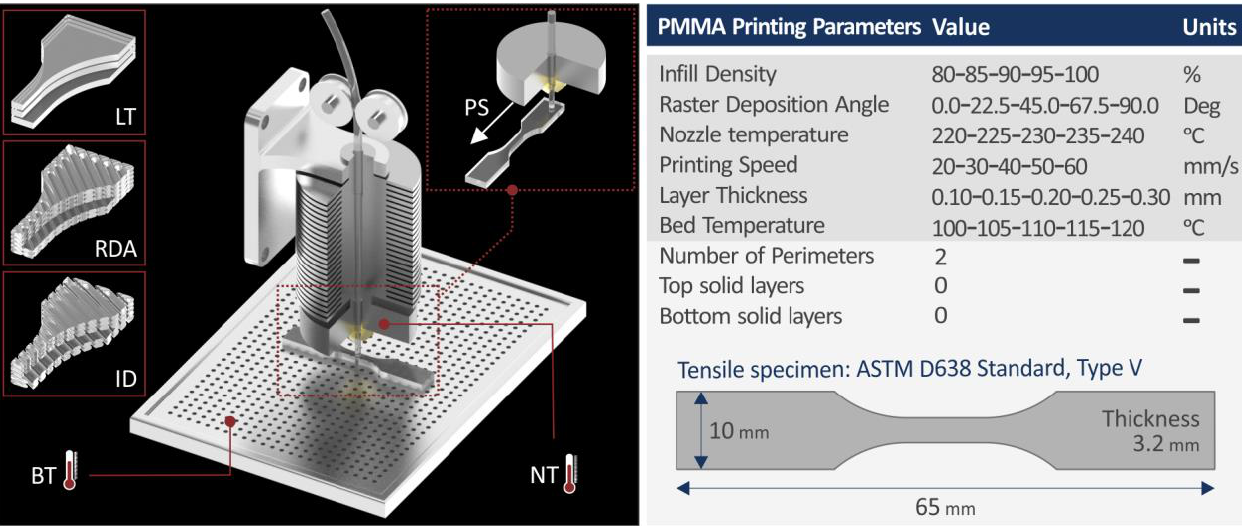
Figure 2. 3D-printing process: graphical representation of the 3D-printing settings considered in the work, their values (right side), and the dimensions and the specimens manufactured with the process, following the corresponding standard (ASTM D638-02a).